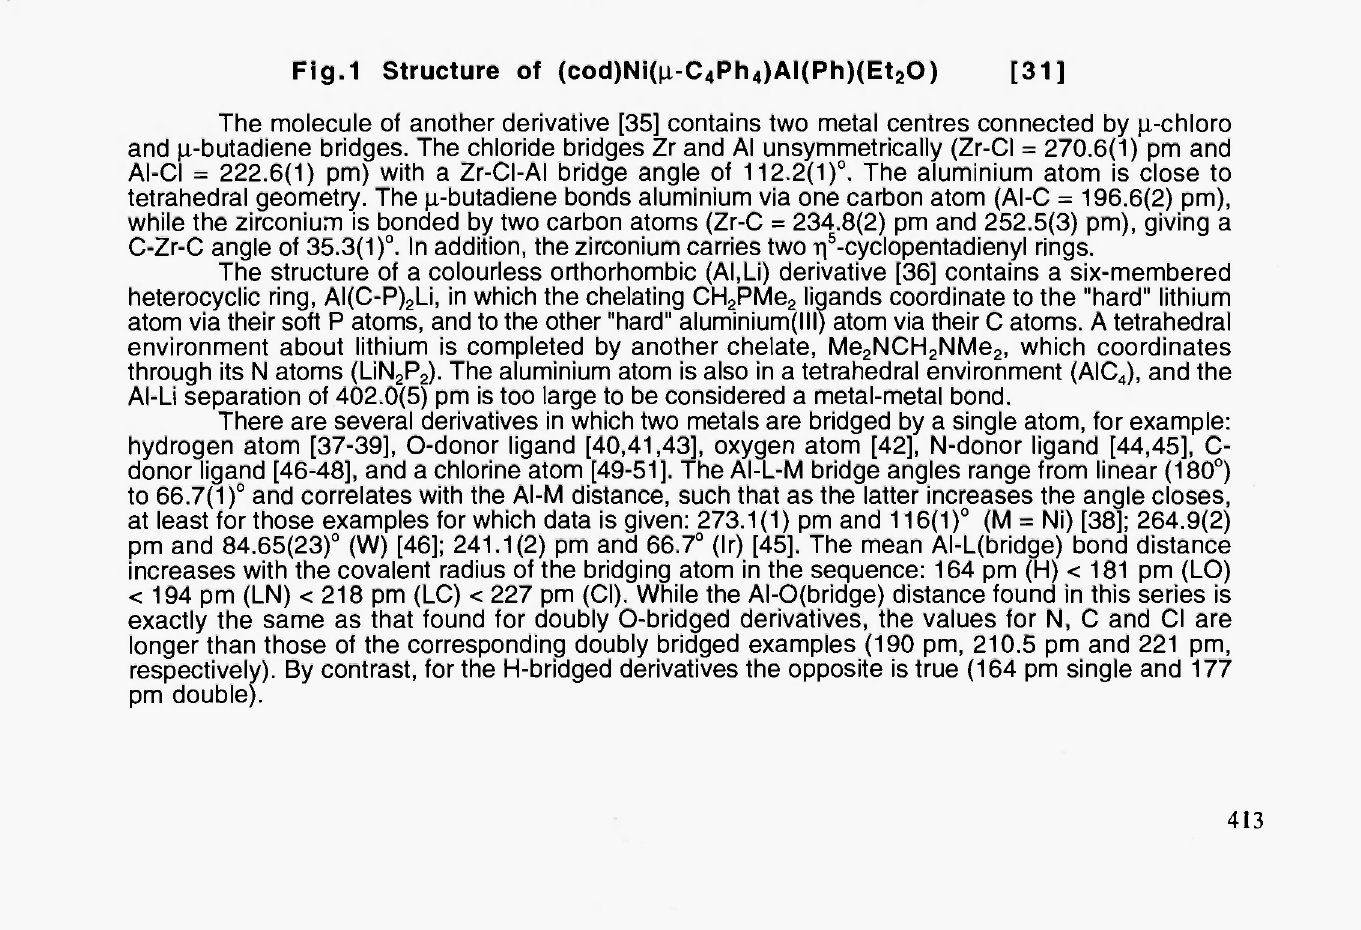
Fig.1 Structure of (cod)Ni^-C 4 Ph 4 )AI(Ph)(Et 2 0)